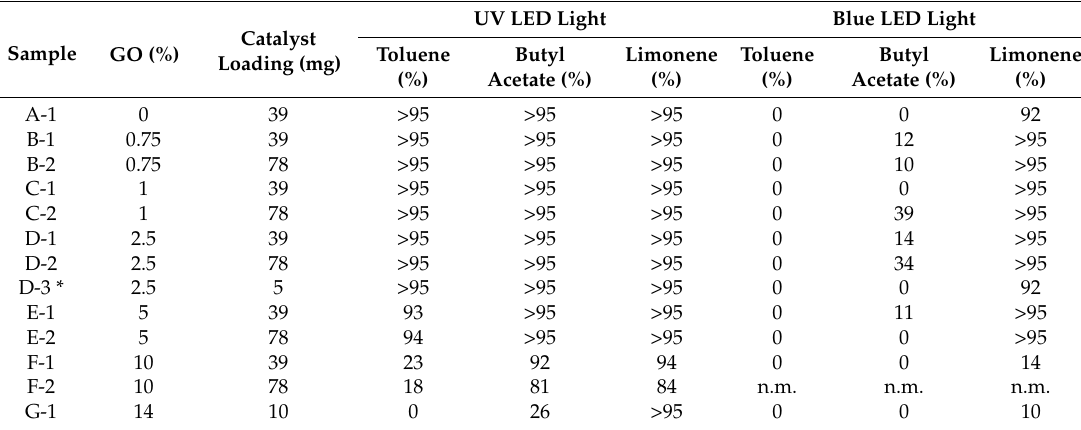
Table 3. Degradation (%) of toluene, butyl acetate and limonene under UV and blue LED